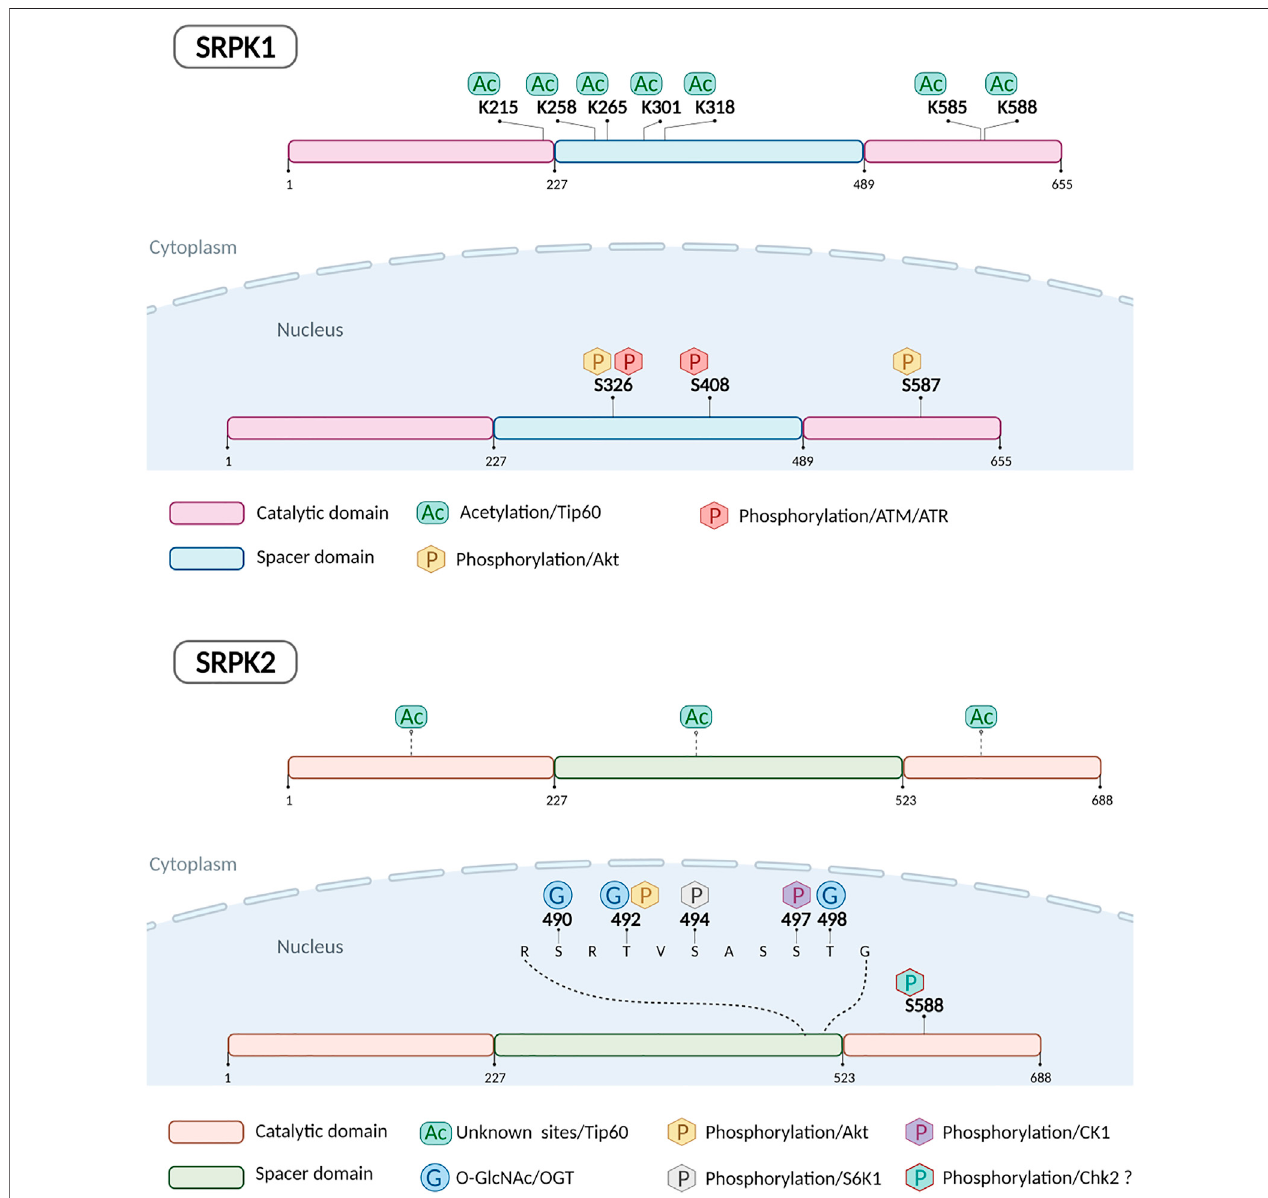
FIGURE 1 | Schematic representation of human SRPK1 and SRPK2 indicating post-translationally modi fi ed amino acids and enzymes responsible.